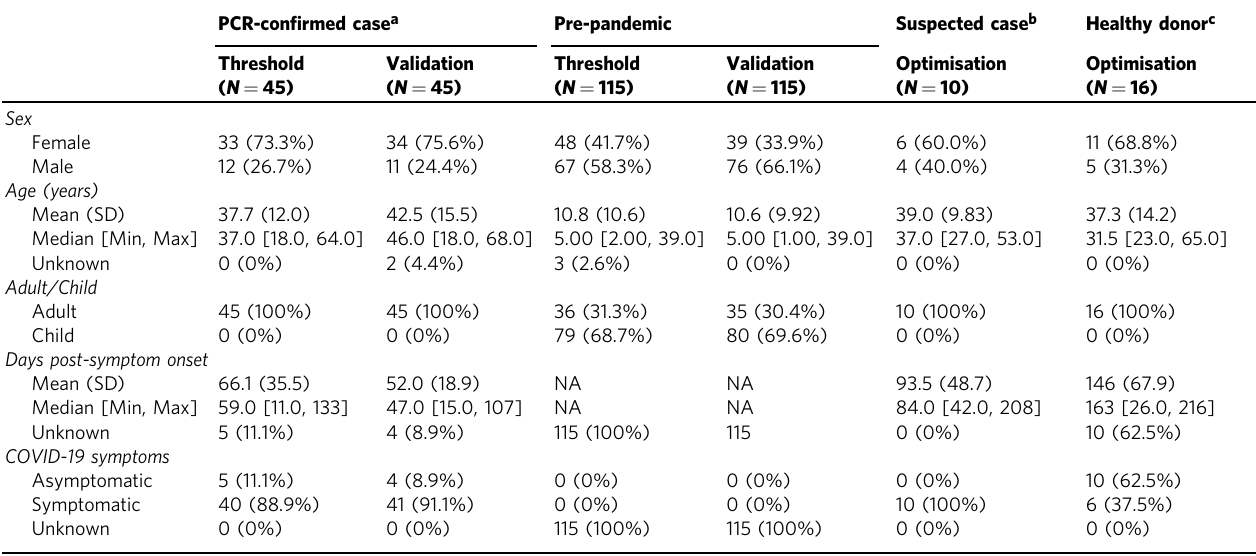
Table 1 Demographic characteristics of samples used in assay development and